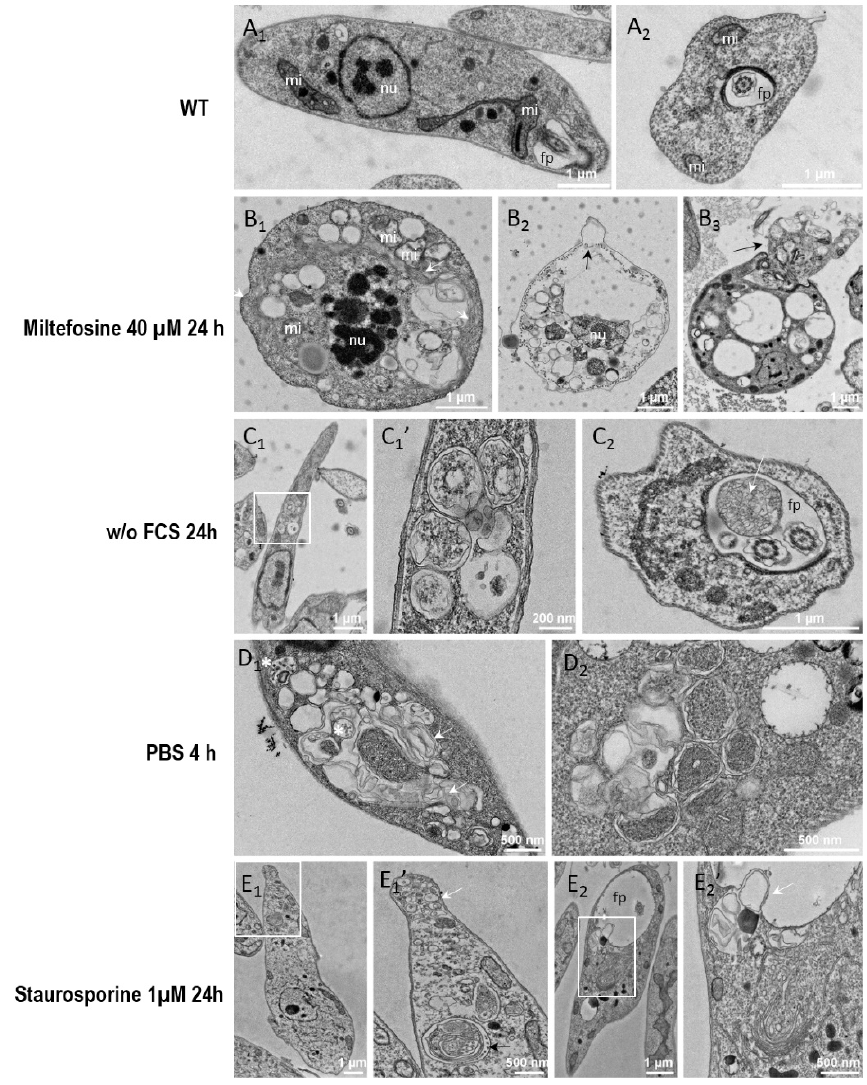
FIGURE 5: Electron micrographs of Leishmania cells during cell death and autophagy. Parasites were cultivated for 24 hours in standard conditions (A 1-2 ) , with 40 µM of miltefosine (B 1-3 ) , in a medium without FCS (C 1-2 ) , for 4 h in PBS (D 1-2 ) , or with 1 µM of staurosporine (E 1-2 ) . On images C 1 , E 1 and E 2 , the white rectangle indicates a region of interest that was imaged at higher magnification shown on the next image. (A 1 ) Longitudinal section of a normal parasite, showing the nucleus, 2 sections of the mitochondrion and the flagellar pocket containing a section of the flagellum. Note that the lumen of the flagellar pocket is electrolucent and does not show any cellular material except the flagellum. The cytoplasm does not usually contain accumulation of simple or double membrane vesicles. (A 2 ) Transversal section through the flagellar pocket of another normal parasite. (B 1 ) Apoptotic cell showing a shrunk nucleus with patches of highly condensed chromatin (nu) and swollen mito- chondrion (mi). The plasma membrane and the subpellicular microtubule network are intact. The cytoplasm is highly vacuolated and shows accumulation of internal membrane multilayers (white arrow). (B 2 ) Cell in late apoptosis or necrosis. Cytosolic components were essentially released, leaving degraded membranous compartments and a shrunk nucleus. Plasma membrane is making blebs (black arrow). Cortical mi- crotubules are still visible but are not attached any longer to the plasma membrane. (B 3 ) Apoptotic cell showing abnormal flagellar pocket partially extruding out of the cellular body (black arrow). (C 1 ) Leishmania cells grown for 24 hours in the absence of FCS (C 1 ) and higher magnification (C 1 ’) . An accumulation of double membrane vacuoles enclosing cytoplasmic material is observed. (C 2 ) Cross-section of the fla- gellar pocket of a cell cultivated without FCS, showing a giant multivesicular body (white arrow). (D 1 -D 2 ) Parasites incubated in PBS for 4 hours present accumulations of vacuoles containing membrane whorls (white arrows) and multivesicular bodies (white asterisk) (D 1 ) and double membrane structures enclosing cytoplasm (D 2 ) . (E 1 ) Parasites treated for 24 hours with 1 µM of staurosporine contain small vesicles accumu- lating at the tip of the cell (white arrow). Complex multimembrane structures containing organelles and cytoplasm can also be observed in vacuoles (black arrow). (E 2 ) The cells present a dilated flagellar pocket. A detail shown in (E 2 ’) , at higher magnification, shows a cytosolic vacuole containing membrane structures in a process of fusion or fission with the flagellar pocket. nu: nucleus; mi: mitochondrion; fp: flagellar